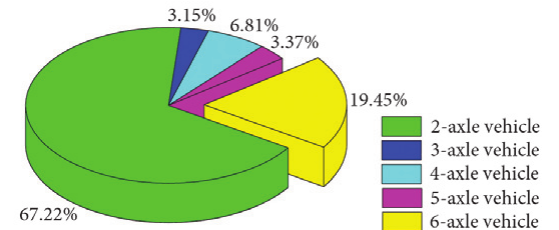
Fig. 4. Proportions of vehicles with different axles